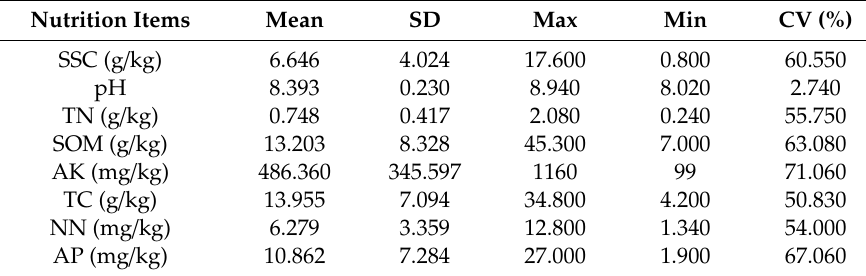
Table 2. Statistical results of soil physical and chemical